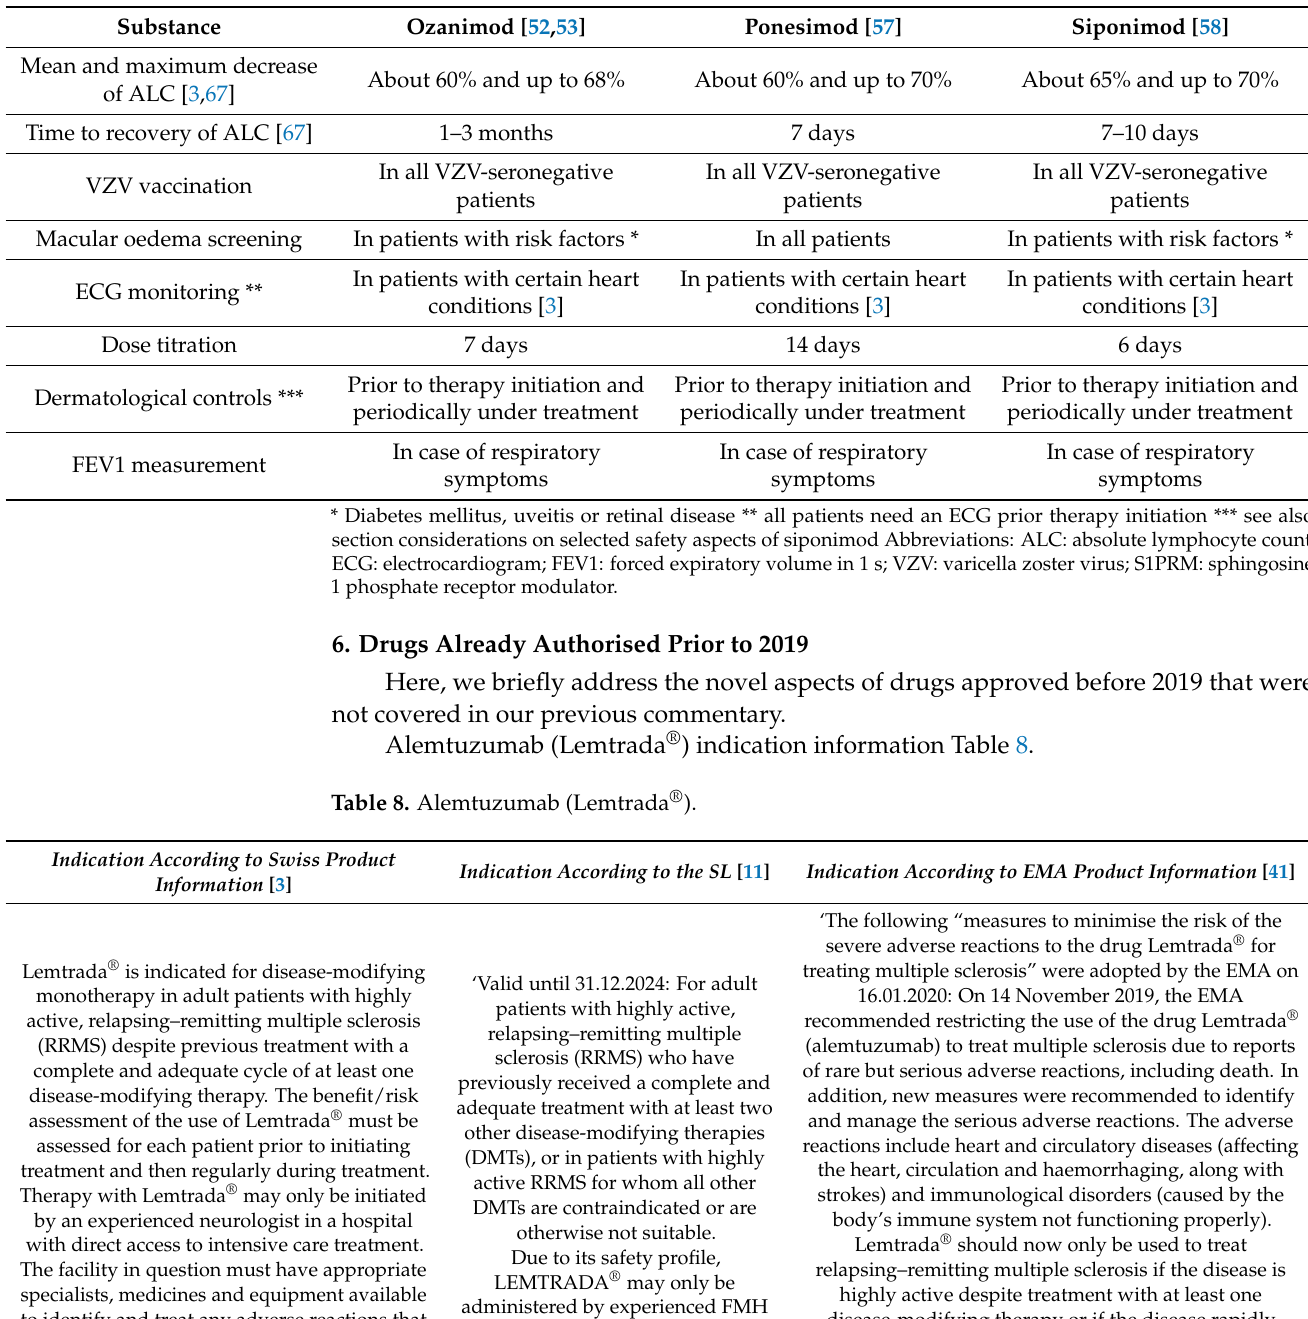
Table 7. Safety aspects and differences between the newly approved S1PRM.